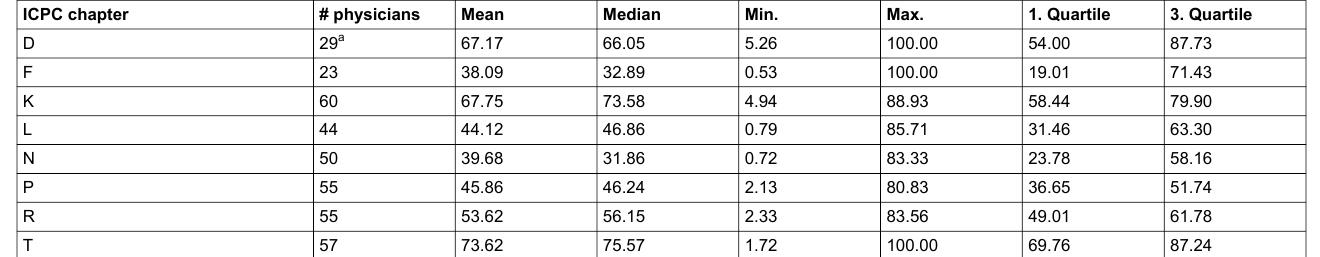
Table 4: Proportions of treatments with a corresponding diagnoses across eight ICPC chapters.